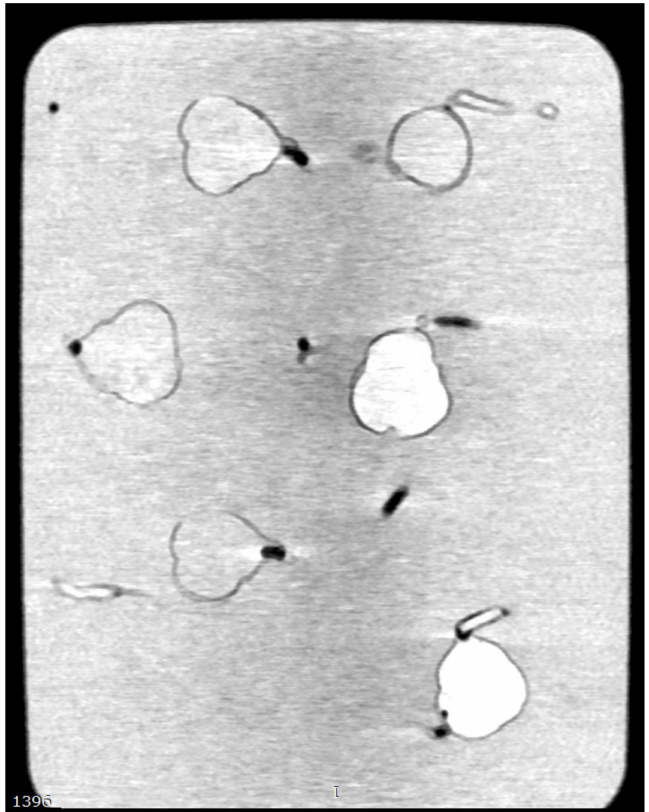
Figure 3. 2D multiplanar coronal reformation shows coronary artery models with contrast medium filling the models and the container. Calcified plaques are difficult to be differentiated from the high attenuation